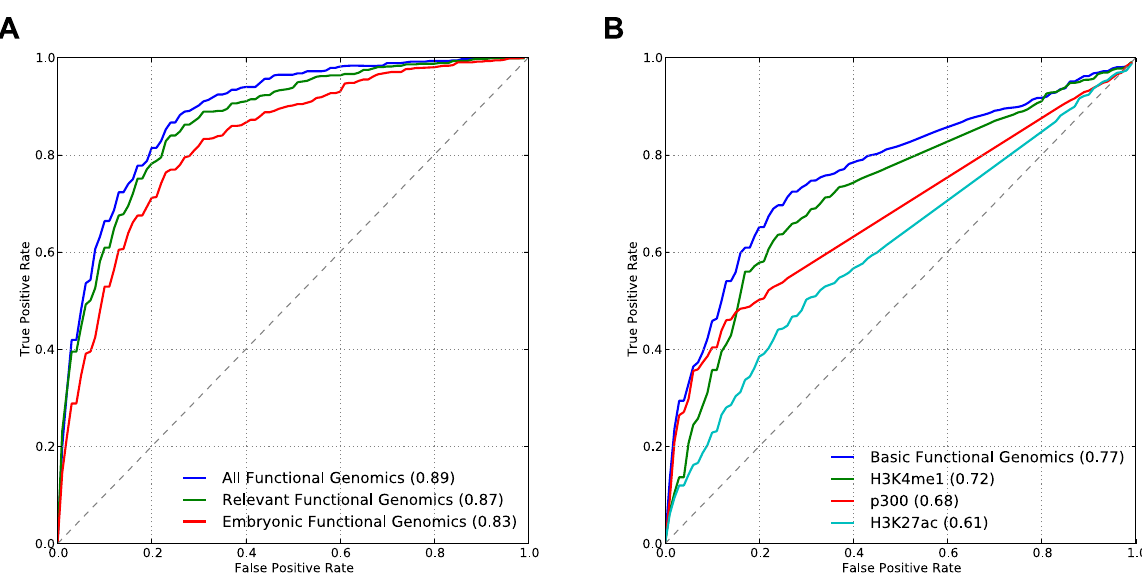
Figure 3. Integrating diverse functional genomics data improves enhancer prediction. (A) Considering functional genomics features from contexts and assays not directly associated with developmental enhancer activity ( All Functional Genomics and Relevant Functional Genomics ) improves the identification of developmental enhancers (p=9.2E-9 and p=2.7E-6, respectively, compared to Embryonic Functional Genomics only). (B) Combining available H3K4me1, p300, and H3K27ac data, which are commonly used in isolation to identify enhancers, in a linear SVM ( Basic Functional Genomics ) is better able to distinguish known developmental enhancers from the genomic background than considering each type of data alone (p , 2E-7, for each). However, combining these marks still performs significantly worse than EnhancerFinder (Figure 2A; AUC=0.96) and considering additional data as in (A).